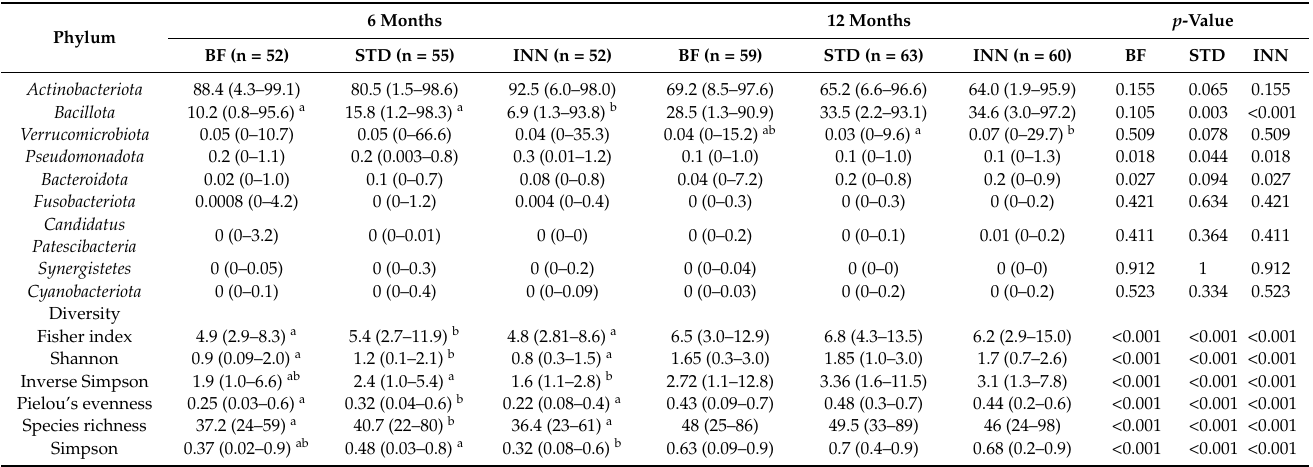
Table 1. Distribution of phyla and alpha diversity indices.